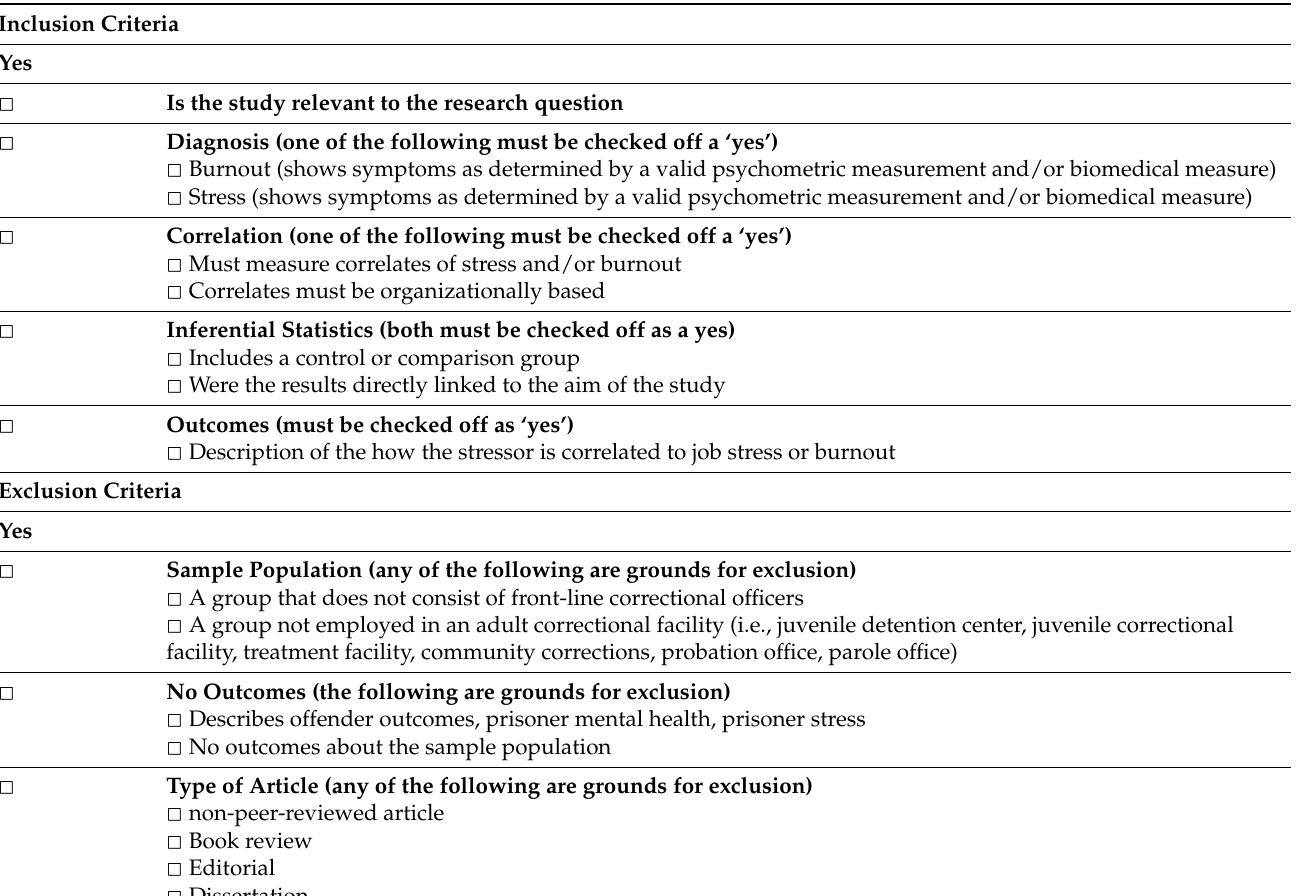
Table 1. Stage 1 Quality Appraisal